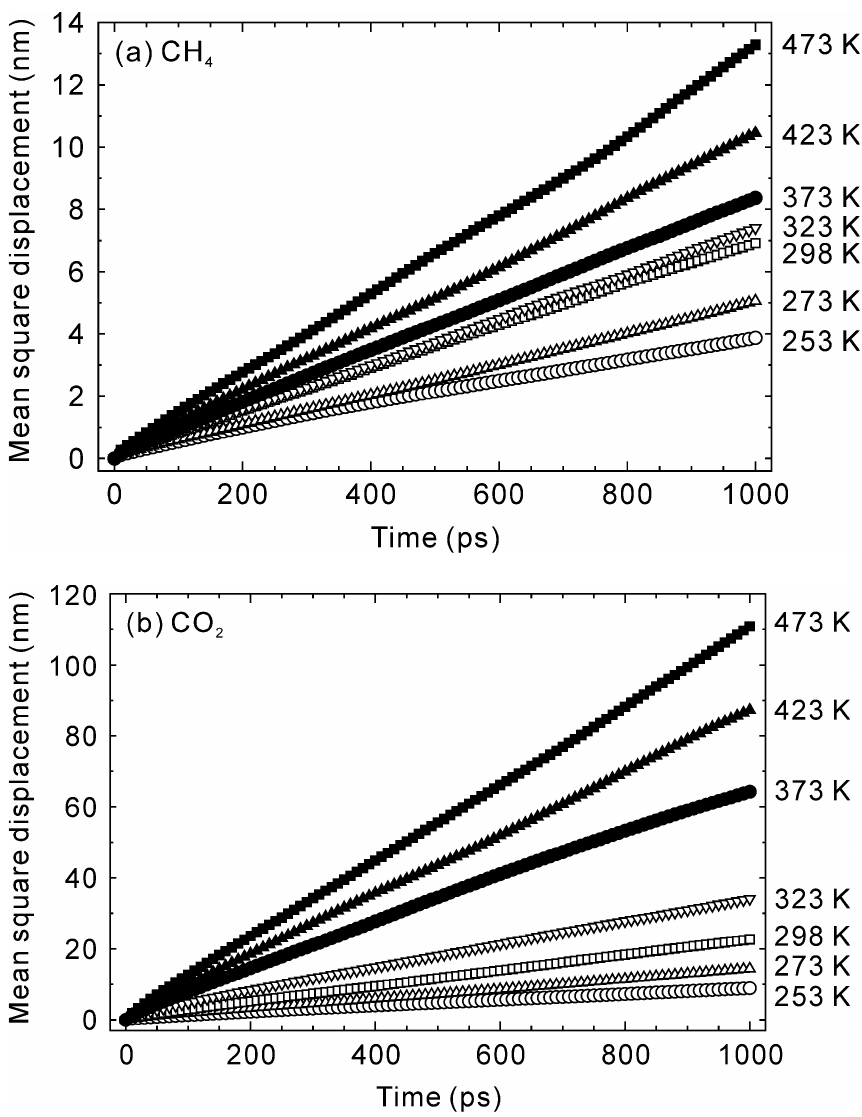
Figure 5. Time courses in the mean square displacements of ( a ) CH 4 and ( b ) CO 2 at 253 – 473 K.